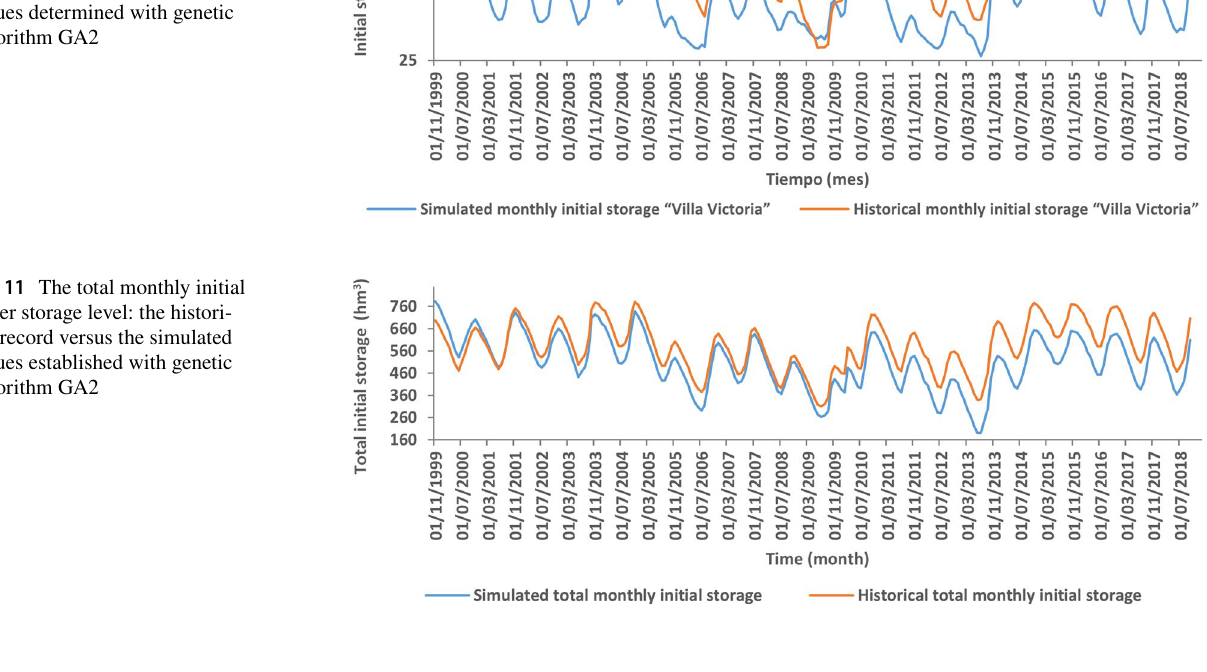
Fig. 10 The monthly initial water storage level of the Villa Victoria reservoir: the historical record versus the simulated values determined with genetic algorithm GA2